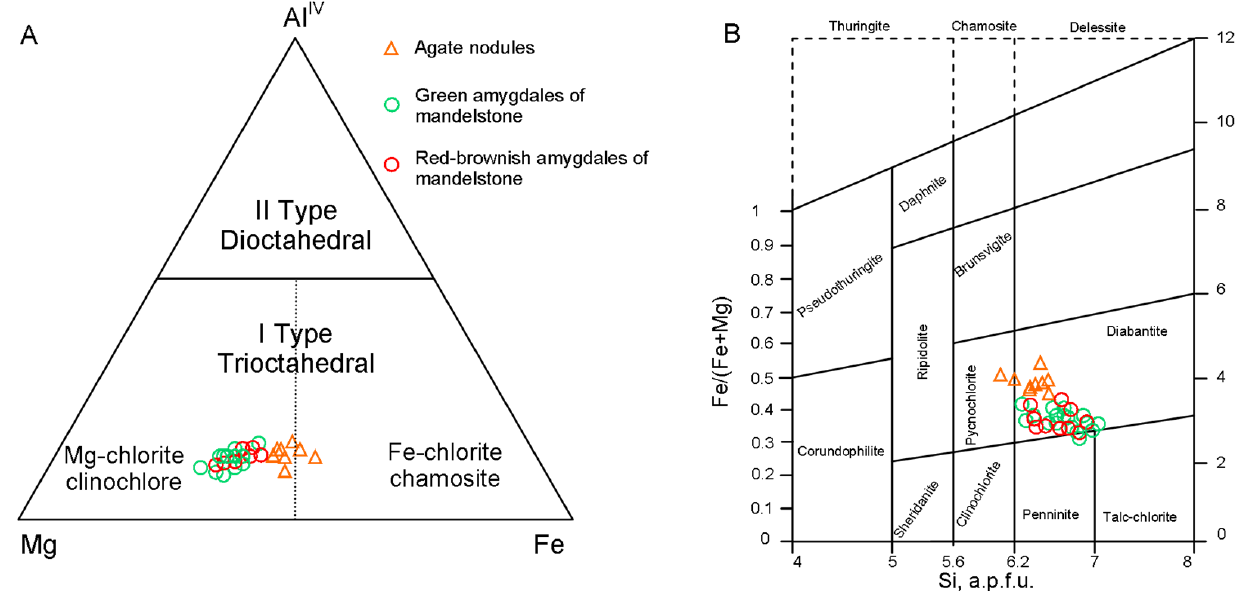
Figure 11. Chlorite classification diagrams showing the position of the investigated samples of the agates. ( A ) (Al)–Mg–Fe diagram (after [33]); ( B ) Si vs. Fe/(Fe+Mg) diagram (after [34]).